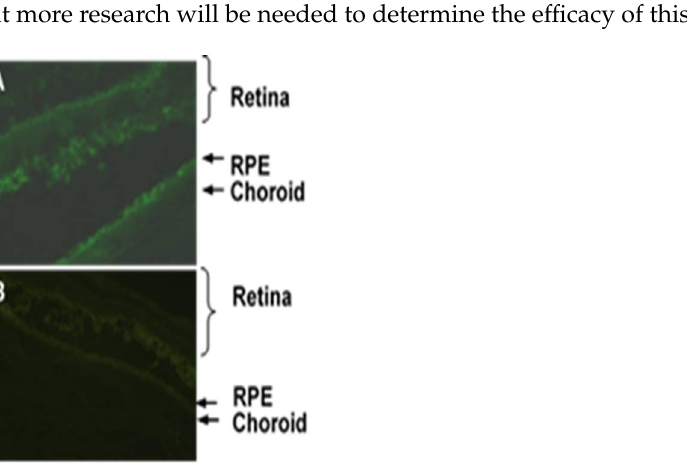
Figure 4. Topical Administration of FITC-APNp1 ( A ) or PBS ( B ) 3 times a day for 7 days. ( A ) Topical APNp1 reached the retina, RPE, and the choroid. ( B ) Weak flourescence was noted with the controls.